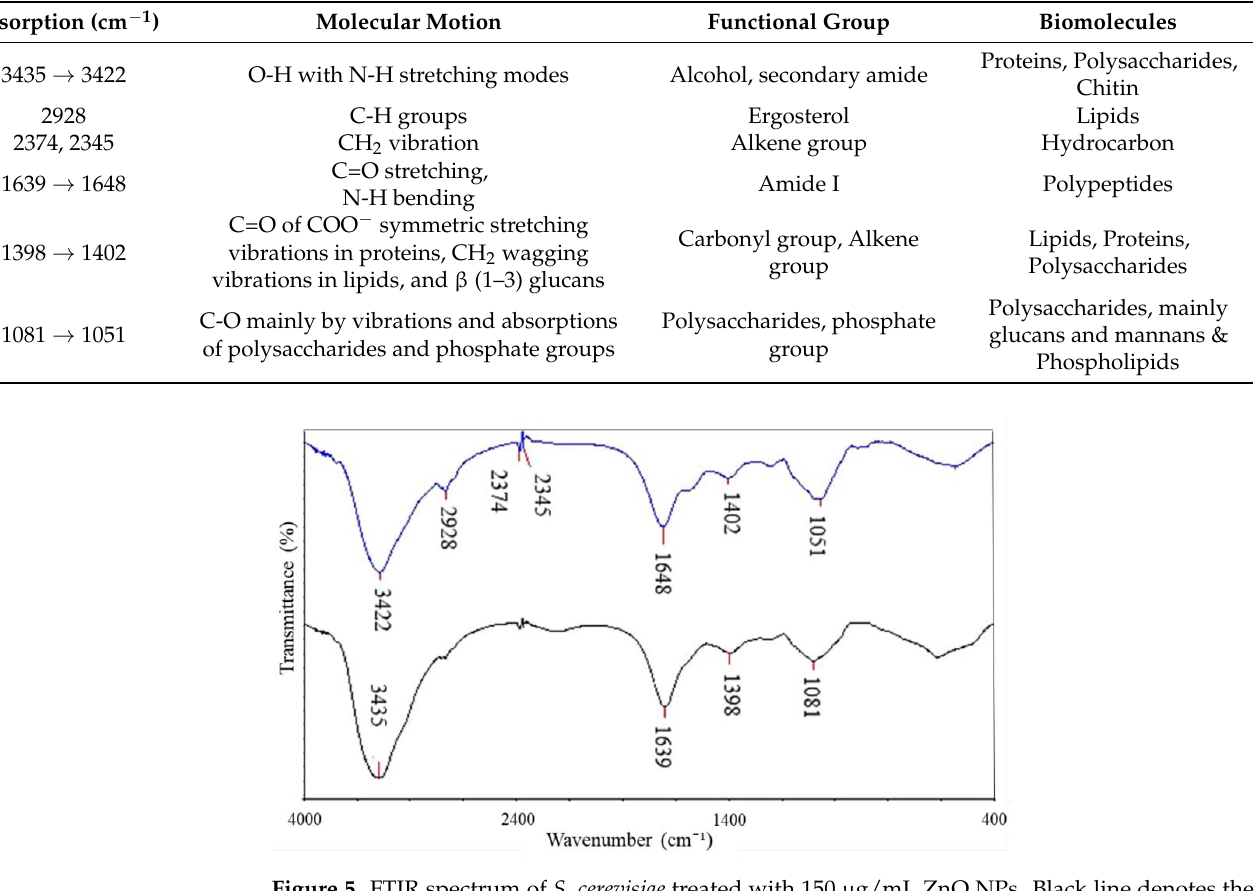
Figure 5. FTIR spectrum of S. cerevisiae treated with 150 μg/mL ZnO NPs. Black line denotes the negative control, while blue line denotes the sample treated with 150 μg/mL ZnO NPs.